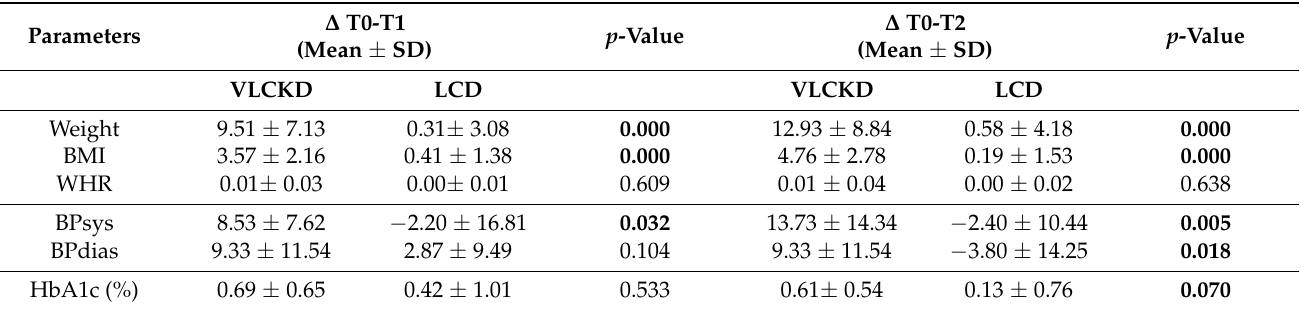
Table 4. Mean differences ( ± SD) between baseline (T0), 3 months (T1) and 12 months (T2) in VLCKD and LCD groups.